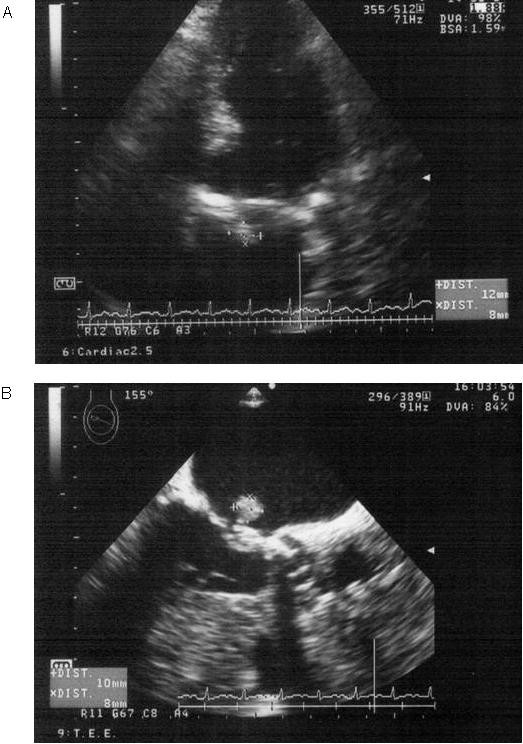
Transthoracic echocardiogram (A) and transesophageal echocardiogram (B) performed on day 13 revealed vegetation on the mitral valve.